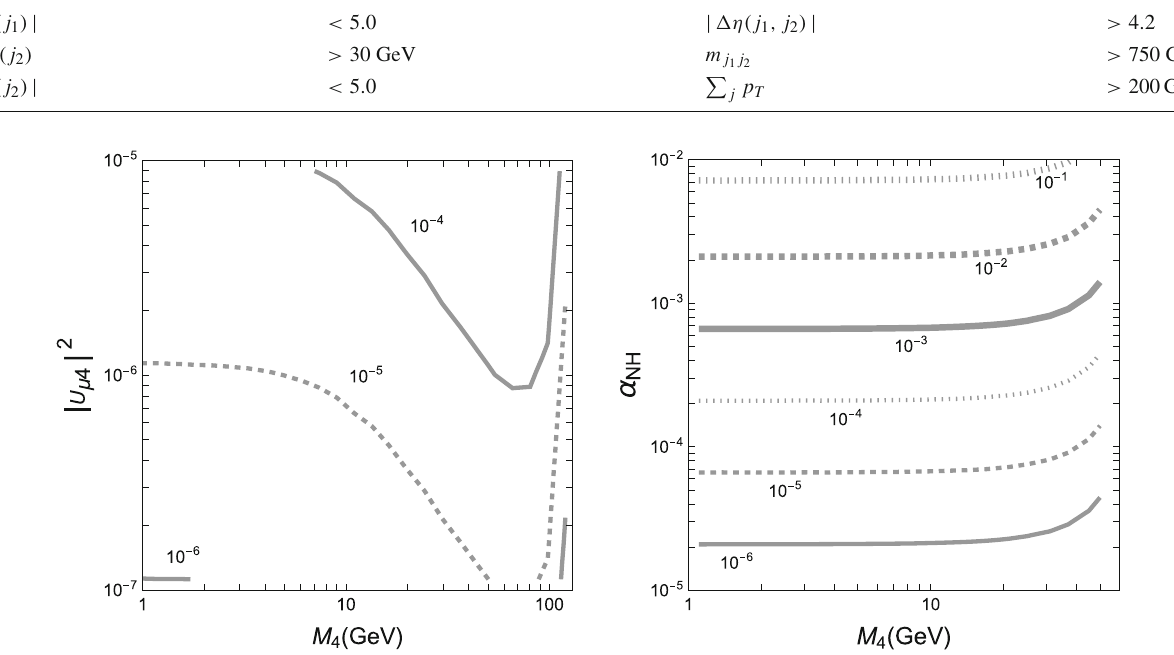
Fig. 1 Different contributions to heavy neutrino production by VBF. V denotes W ± or Z bosons Table 1 VBF selection criteria, where j 1 and j 2 refer to the two most energetic jets, and the sum is over all hadronic activity